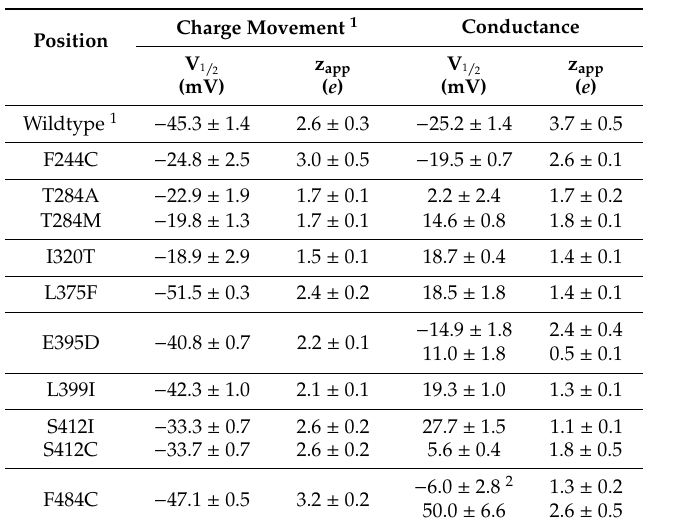
Table 2. Voltage dependence of gating charge movement and conductance of the EA1